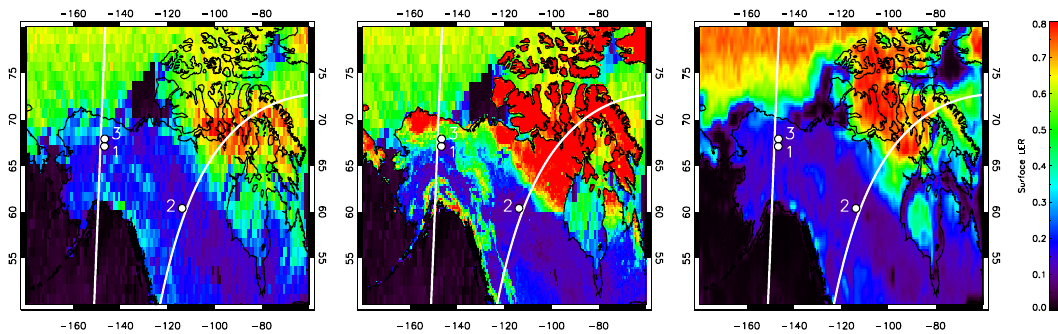
Figure 2. Geophysical location of the three cases in North America studied in this paper. Case 1: 67.2 ◦ N, 146.3 ◦ W; case 2: 60.4 ◦ N, 113.6 ◦ W; case 3: 67.9 ◦ N, 146.3 ◦ W. All three cases constitute cloud-free scenes over land. The two white curves indicate the edges of the GOME-2 orbit swath. Each of the three panels contains a different background. This background represents the 772nm surface LER product of GOME-1, MERIS and GOME-2, respectively, for the month May. Obviously, there are significant differences which can have a large impact on the outcome of the simulations performed in this